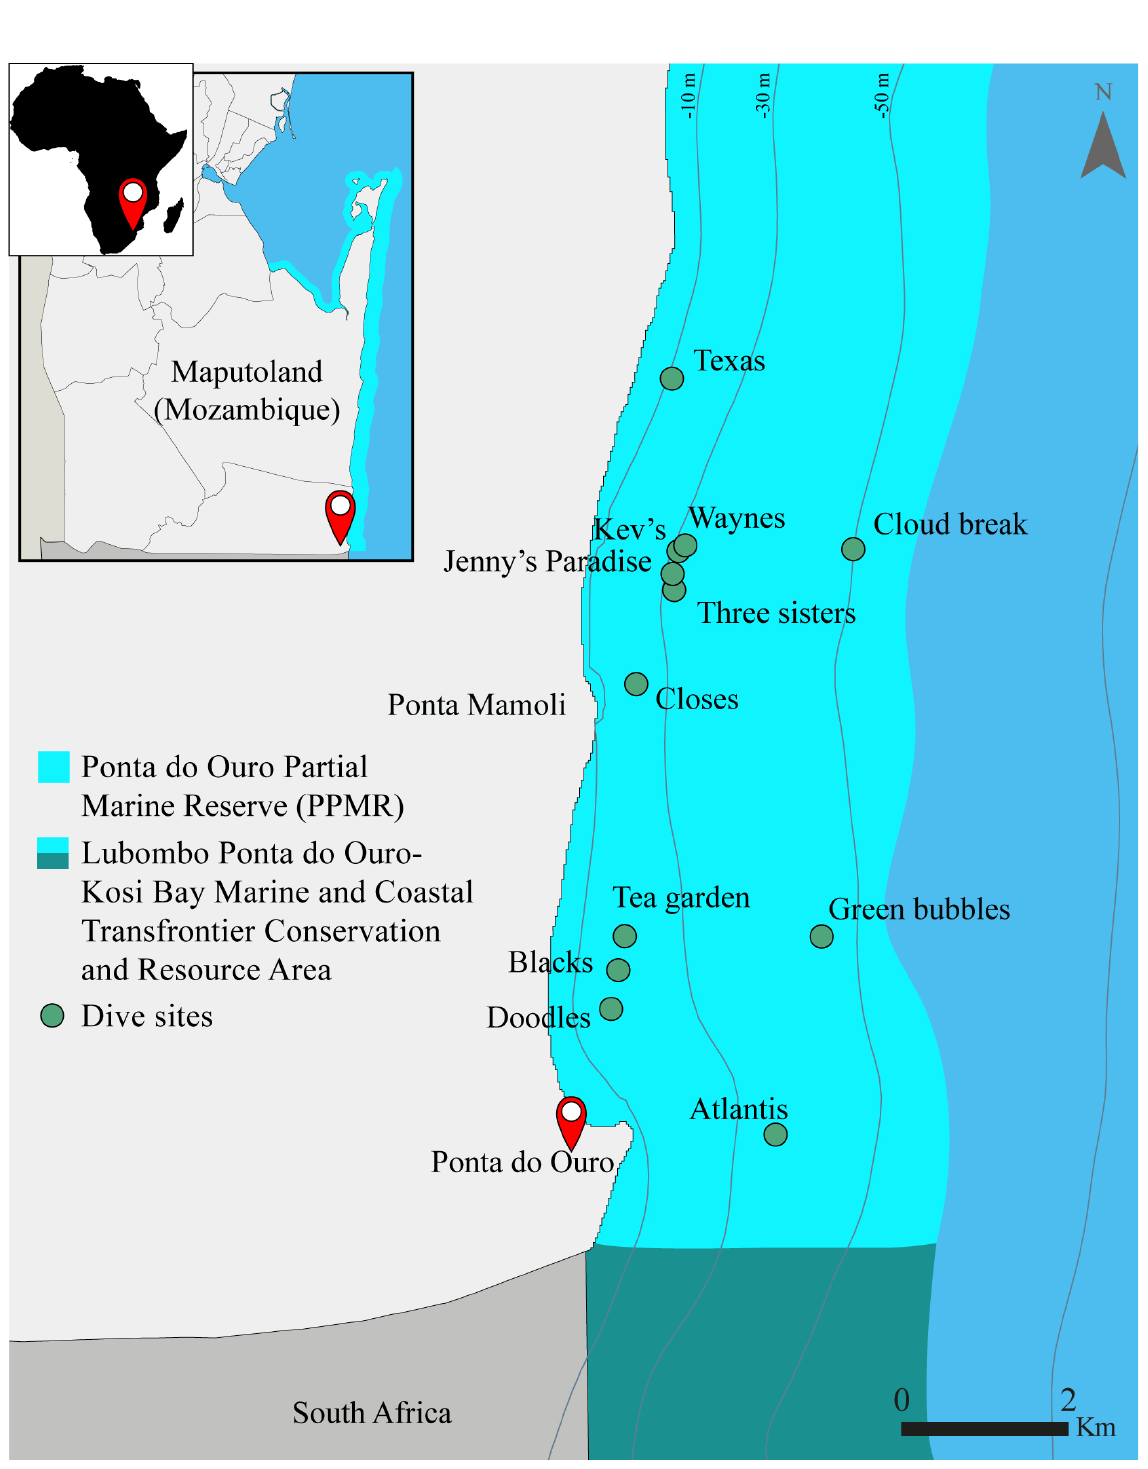
Fig. 1. Map of the coast of Mozambique where Ponta do Ouro, the partial Marine Reserve and dive sites for sampling are